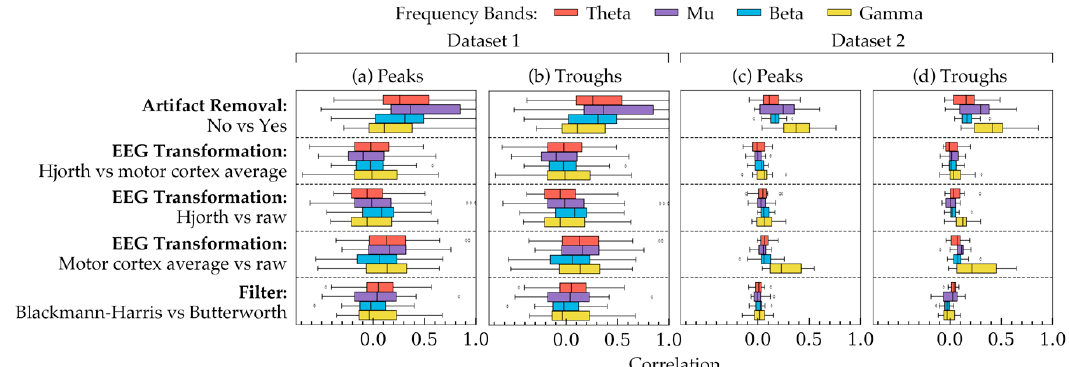
Figure 5. The correlation coefficients, calculated using phases from all subjects, showing how choices in each method are correlated to each other. The coefficients are shown for ( a ) the peak phase trials within all subjects in Dataset 1, ( b ) the trough phase trials within all subjects in Dataset 1, ( c ) the peak phase trials within all subjects in Dataset 2, and ( d ) the trough phase trials within all subjects in Dataset 2. Each row, separated by a dashed line, represents the correlation between a pair of choices within a method. The remaining two methods were kept constant for each row. The constant values were as follows: artifact removal = yes, EEG transformation = raw, filter = Butterworth. The four frequency bands are highlighted in four different colors. The boxes indicate the quartiles of the samples while the whiskers extend to show the rest of the distribution up to 1.5 inter-quartile range. The dots indicate the outliers in the figure.